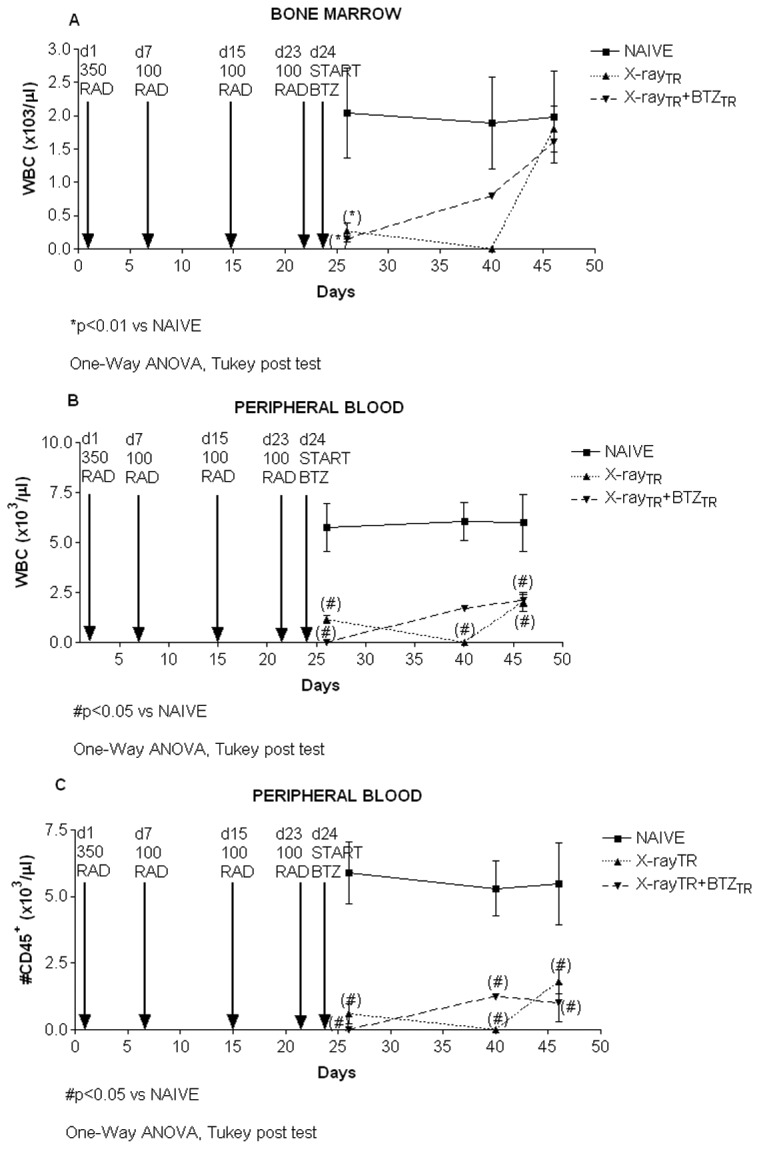
Bone marrow and peripheral blood and bone marrow white blood cells (WBC) count and FACS analysis, experiment 2.Black arrows indicate the treatment given to mice, such as the X-ray irradiation doses (350 RAD induction and 100 RAD maintenance), and bortezomib administrations. For each group of animals, the WBC concentration within the BM (A) or peripheral blood (B) is indicated for the corresponding analysis time point. The number of hematopoietic cells in the peripheral blood expressing the pan-leukocyte antigen CD45 is also reported (C). A comparable immune-suppression was observed in both X-Ray and X-Ray-bortezomib-treated animals after the irradiation induction and maintenance doses, as shown by the decreased cellularity and leukopenia in the BM and spleen of irradiated mice, regardless of bortezomib treatment.